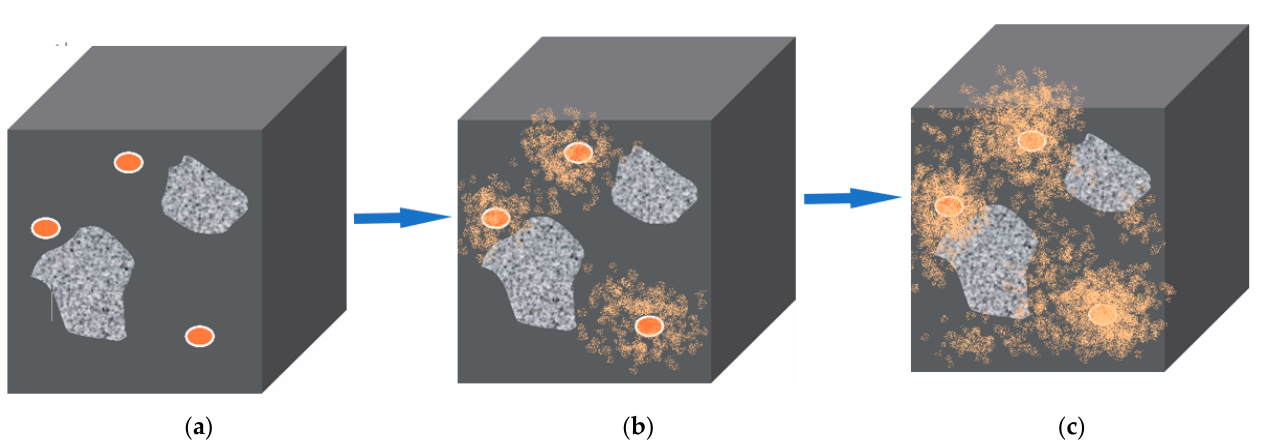
Figure 13. Illustration of the self-healing process of an asphalt sample with microvasculars containing rejuvenator, ( a ) rupture interface of an asphalt sample with broken microvasculars, ( b ) rejuvenator release out of microvasculars, and ( c ) rejuvenator diffusion continuously into asphalt under a certain temperature with time extension.